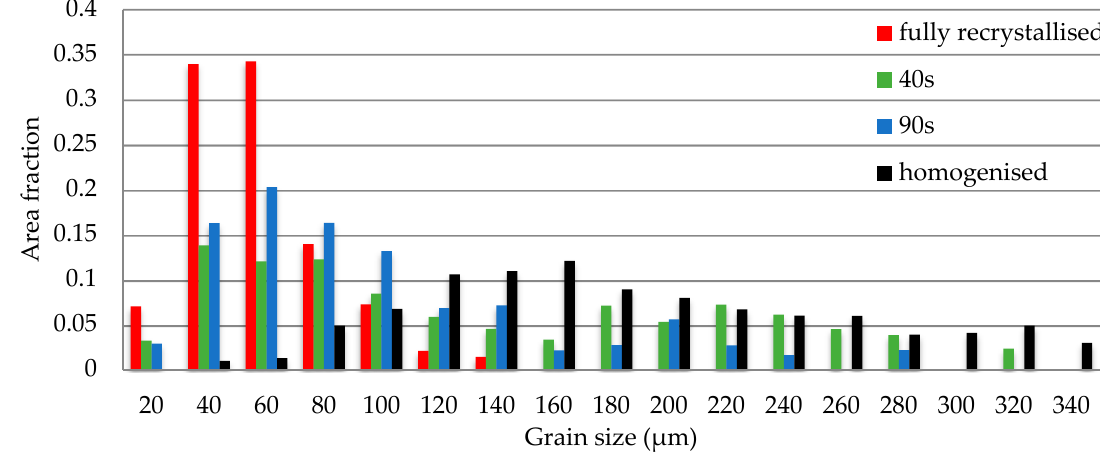
Figure 7. The grain size distribution of homogenised, 40 s (30% recrystallised), 90 s, (50% recrystallised) and fully recrystallised samples.